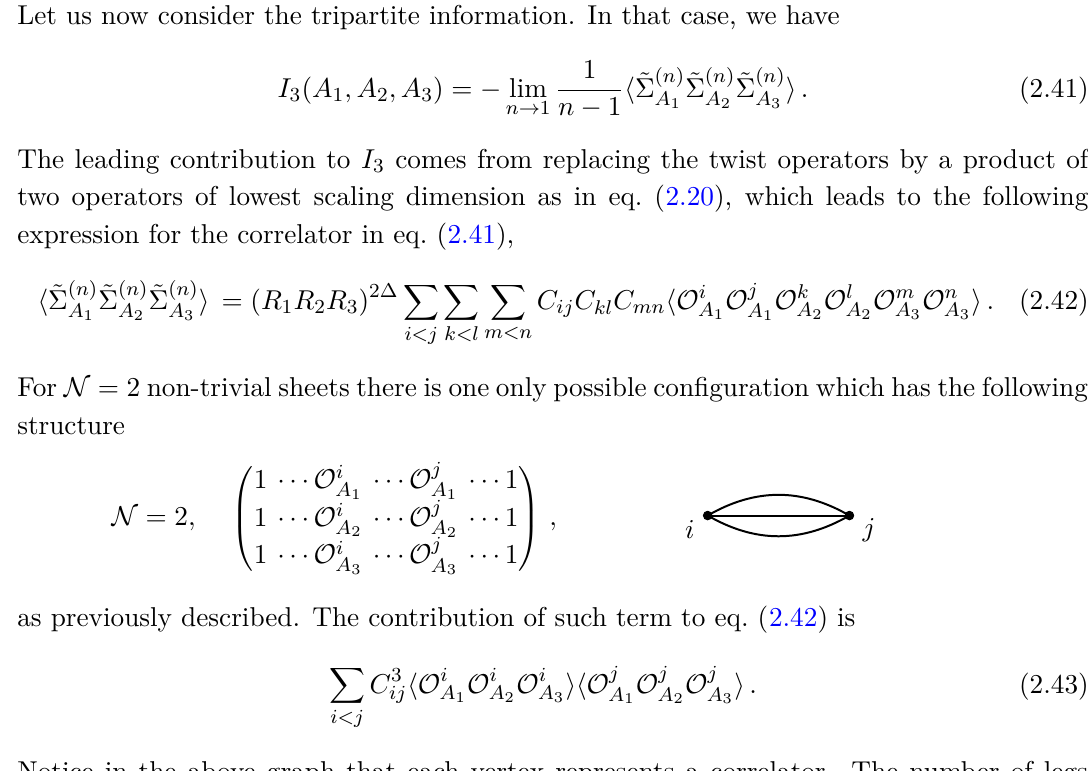
Figure 1 . Graph representation of the mutual information. The result involves the square of the correlator of the primary operator with the lowest conformal dimension of the theory. In each correlator, the primary is defined at two points lying at the (centers of each of the)